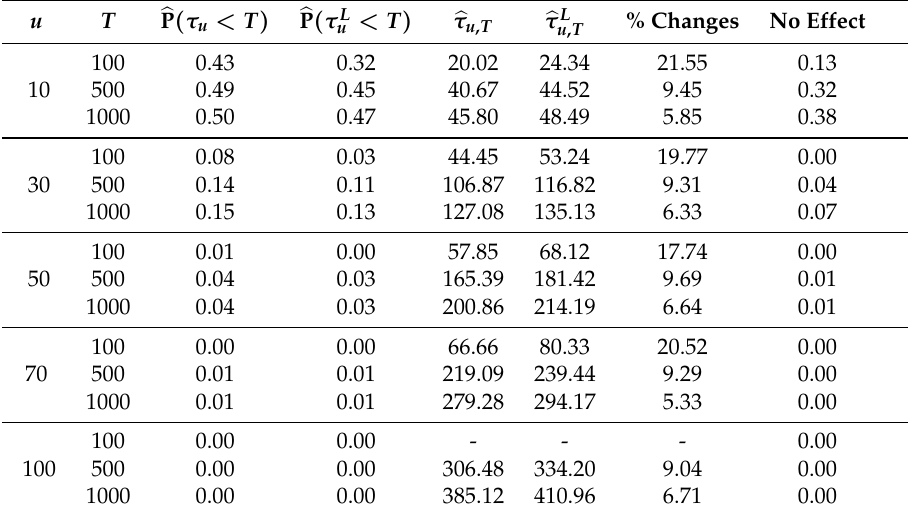
Table 5. EOL reinsurance for Gamma ( 2,1 ) distributed claims. The safety loading is θ = 0.1, expected claim size is µ = 2, claim arrival rate is λ = 1, and each time unit is 0.01 years. Simulations are done with N = 100,000 sample paths. Retention level L is the solution to (17). For T = 100,